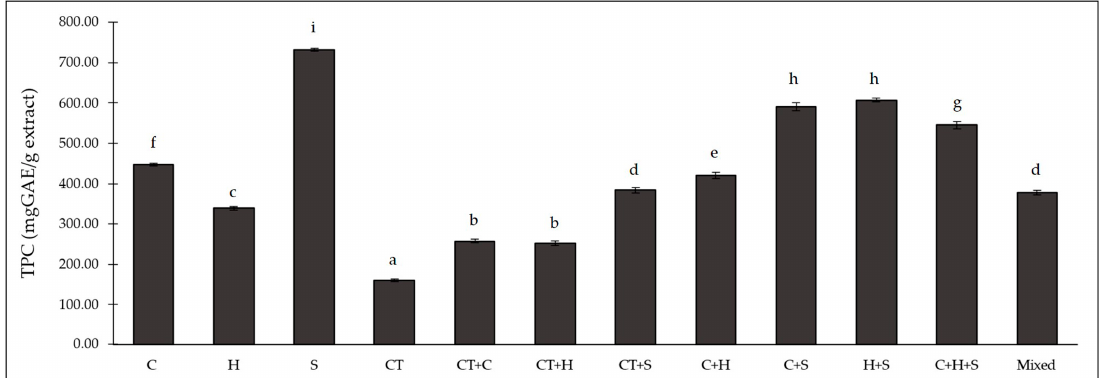
Figure 1. Total phenolic acid content (TPC) in different extracts from purple corn and butterfly pea. C: cob extract; H: husk extract; S: silk extract; CT: butterfly pea extract; CT + C: butterfly pea and cob extract; CT + H: butterfly pea and husk extract; CT + S: butterfly pea and silk extract; C + H: cob and husk extract; C + S: cob and silk extract; H + S: husk and silk extract; C + H + S: cob, husk, and silk extract; mixed: combination of butterfly pea, cob, husk, and silk extracts. The different superscript letters (a–i) indicate a significant difference between each content of the extracts using Tukey’s test ( n = 3, p < 0.05).